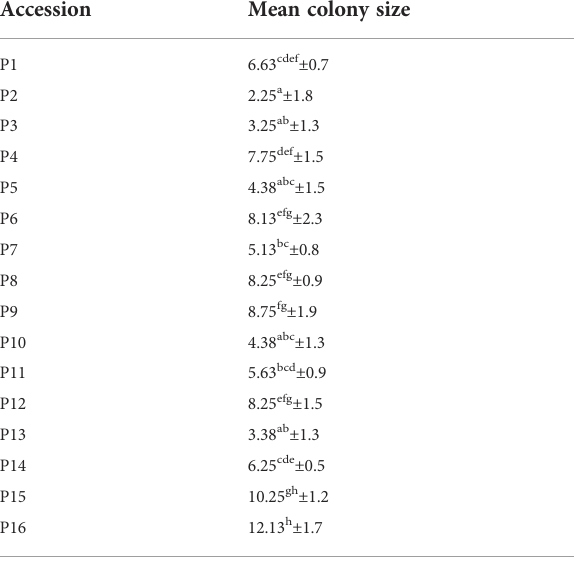
TABLE 2 Mean colony size of A. pisum on 16 lentil accessions, measured as mean number of aphids on each genotype.